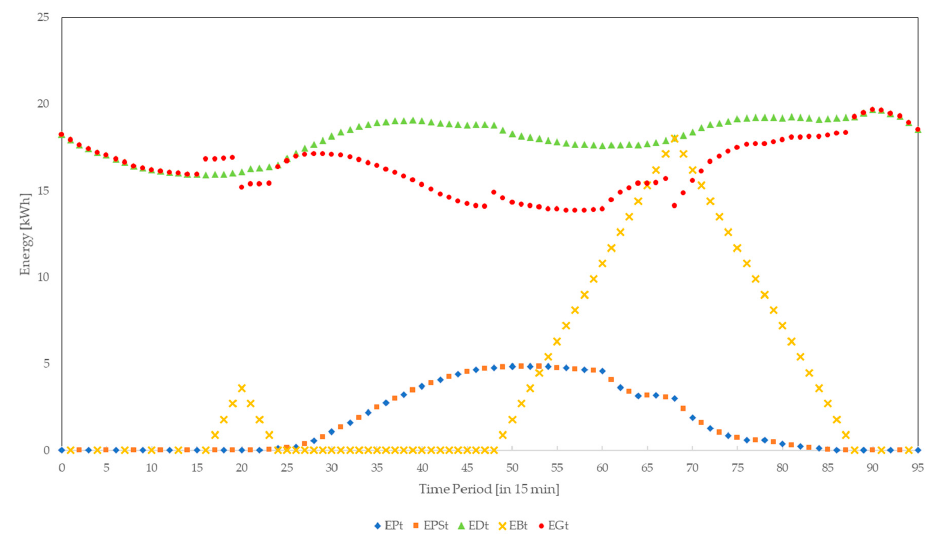
Figure 10. Graphic analysis of the effects of an integrity attack on photovoltaic energy data.